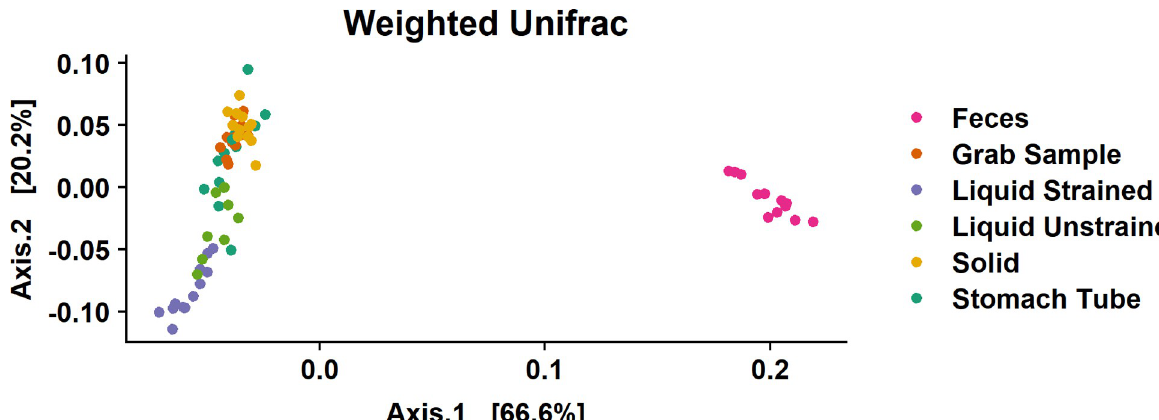
Fig 3. Beta diversity as weighted UniFrac distances between samples. To faithfully reflect the variance in the coordinates, the height-to-width ratio was based on the ratio between the corresponding eigenvalues.